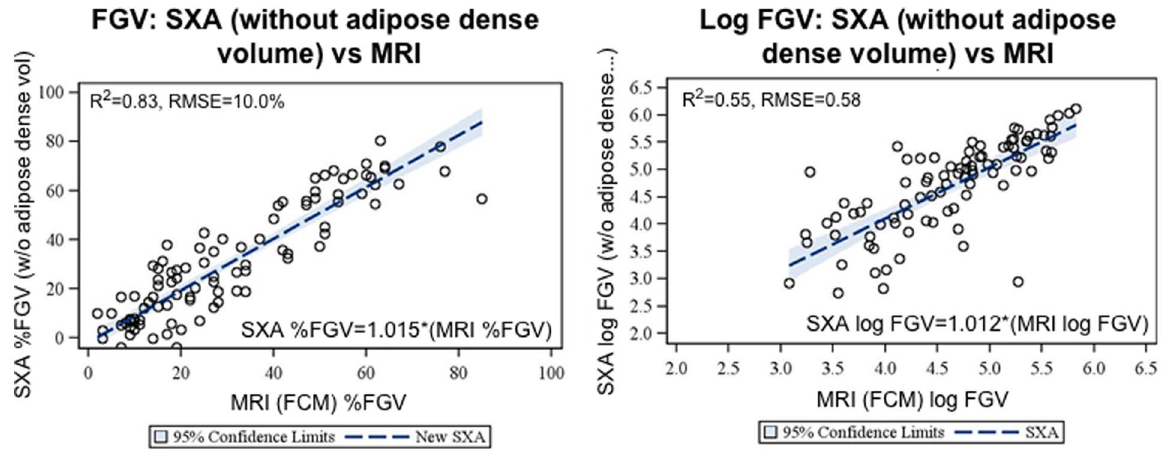
Figure 3. Validation of SXA model using breast biology and adipose volume estimates from MRI. The amount of water volume in the MRI adipose volume was estimated to be 15% of the volume, which is consistent with previous work estimating it to be between 8% [34] and 20% [35]. The MRI model does not include adipose density in the fibroglandular volume while SXA does. Subtracting out the adipose water volume from the SXA fibroglandular volume improved the agreement between SXA and MRI from R 2 =0.78 to 0.83 and removed most of the bias between the measures.